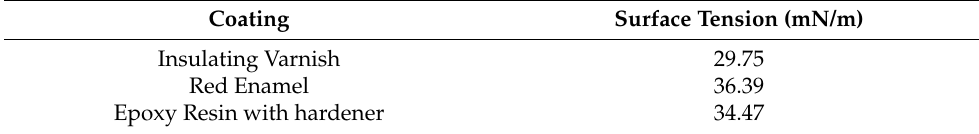
Table 2. Surface tension of the coating-air interface on different coatings.